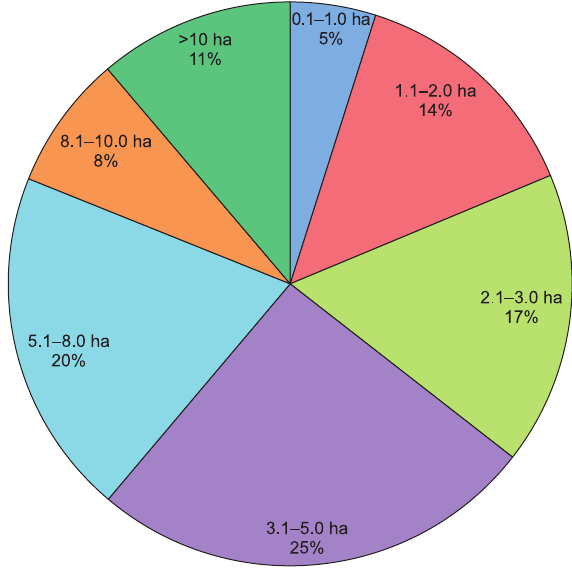
Fig. 3. Agricultural land by size.